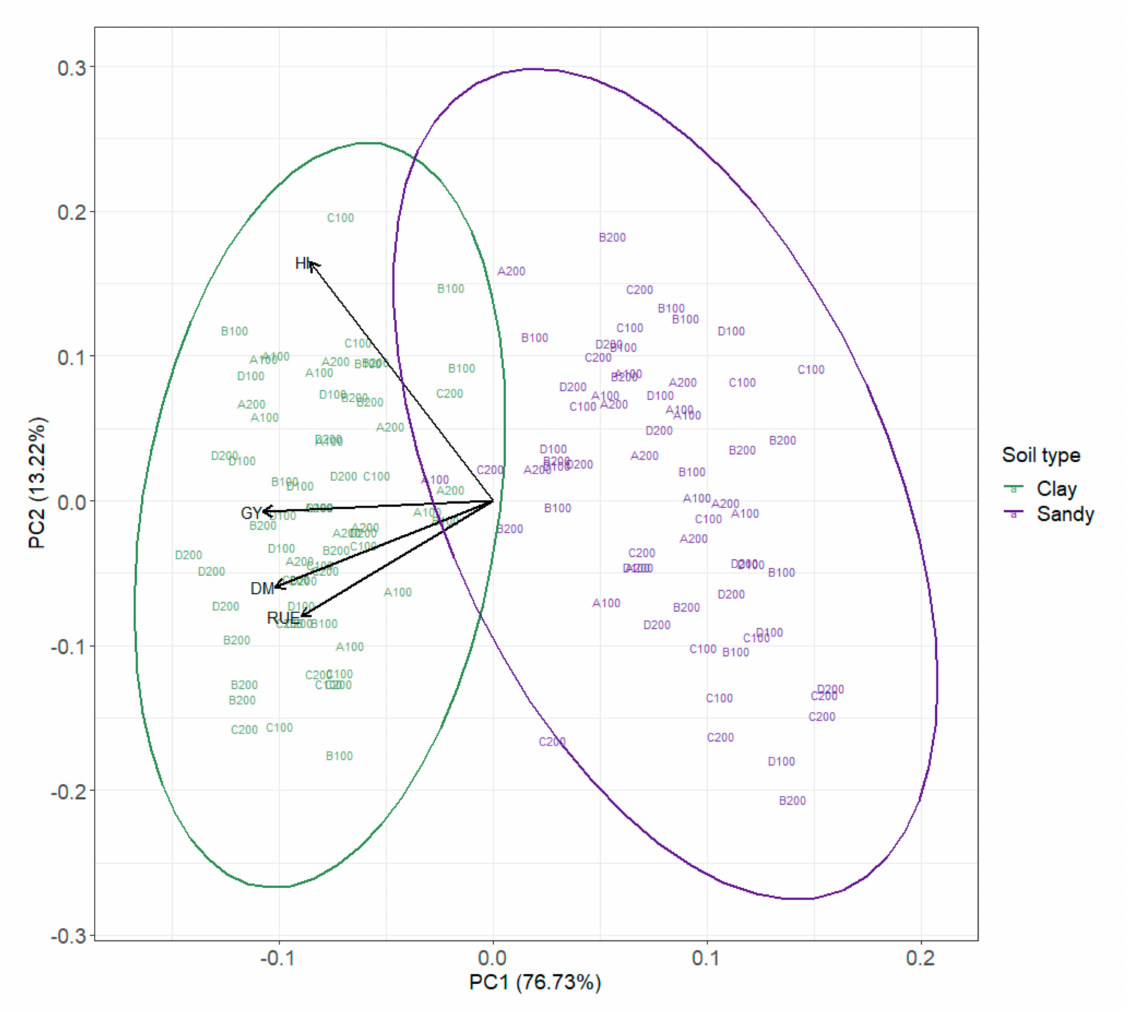
Figure 4. Principal component analyses (PCA) of the selected parameters measured on four spring wheat cultivars (A, B, C, and D—Quintus, Scirocco, Økilde and Hovsa, respectively) grown on clay or sandy soil with 100 or 200 kg N ha − 1 supply. The parameters are aboveground dry matter (DM), grain yield (GY), harvest index (HI), and radiation use e ffi ciency